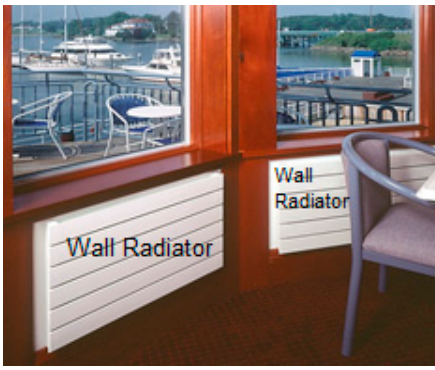
Figure 2. Good view factor between wall radiators and body of occupant seated on chair.